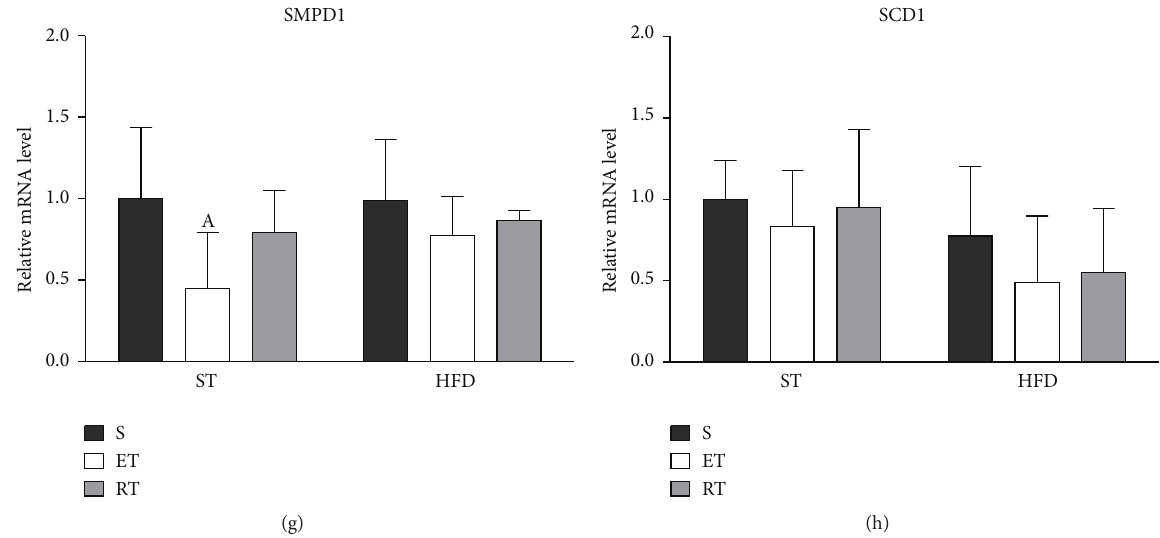
Figure 5: Relative mRNA of genes involved in ceramide biosynthesis pathway in liver of exercise HFD and ST fed mice. A detailed description of the calculation of the relative mRNA levels can be found in Material and Methods. Briefly, all Ct values were transformed into relative quantification data by using the 2 −Δ Ct equation, and the highest relative quantities for each gene were set to 1. (a) CerS2: ceramide synthase 2, (b) CerS4: ceramide synthase 4, (c) ELOVL1: fatty acid elongase 1, (d) ELOVL4: fatty acid elongase 3, ACER2: alkaline ceramidase 2, (f) SPTLC2: serine palmitoyltransferase, long chain base subunit 2, (g) SMPD1: sphingomyelin phosphodiesterase 1 (acid lysosomal), and (h) SCD1: stearoyl-CoA desaturase-1. HFD: high fat diet, ST: standard diet, S: sedentary, ET: endurance training, and RT: resistance training. A: comparison between ST diet groups and corresponding HFD group ( 𝑝 < 0.05 ); #: comparison between sedentary HFD group and the exercised HF